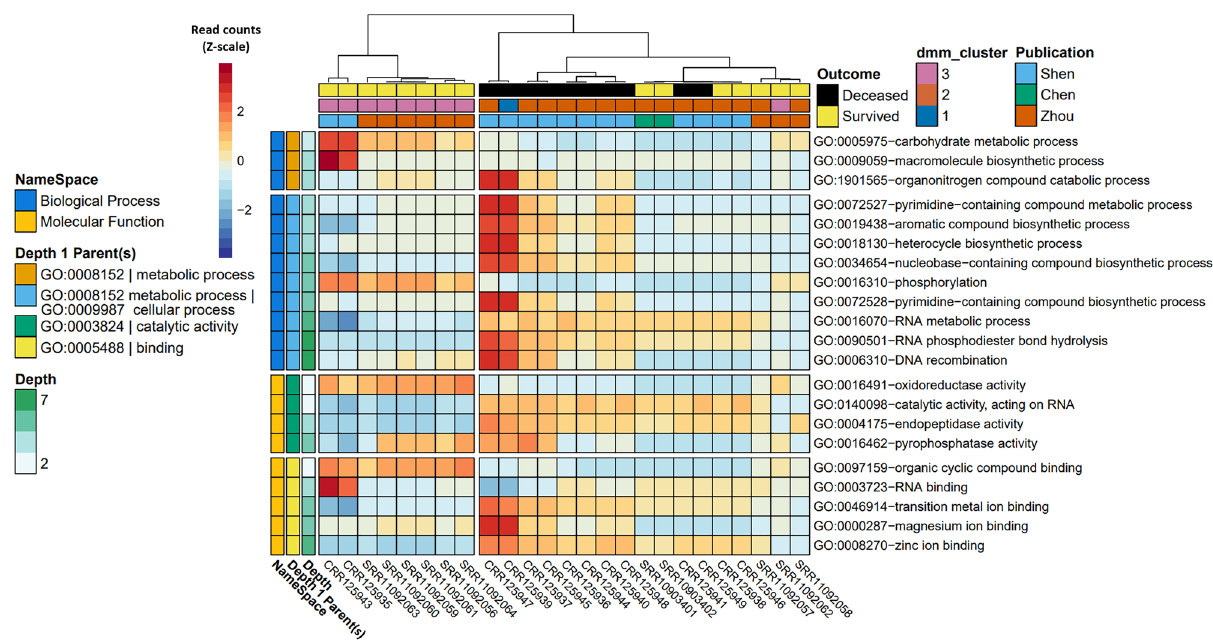
Figure 3. Heatmap of significantly different gene ontology terms associated with COVID-19 mortality comparing deceased (n = 10) versus survived (n = 15). Cells are colored via z-scale calculations of the total read counts by sample (x axis) and by GO term (y axis). Rows are sorted by parental GO terms (depth = 1) and columns are clustered by Euclidean distance using ward D2 clustering. Comparisons were conducted using MaAsLin2, controlling for patient ID with Benjamini Hochberg multiple test comparison (q <